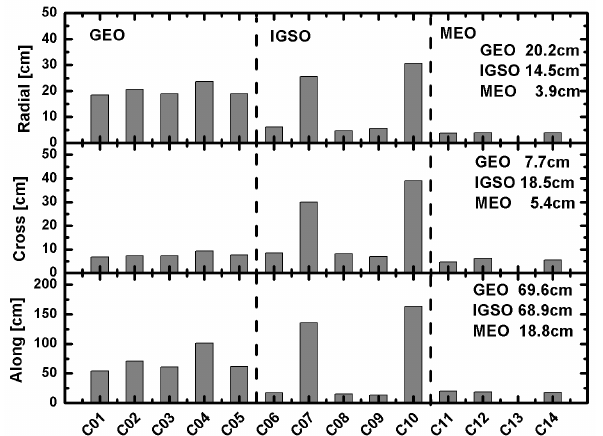
Figure 4. Mean RMS of BDS overlap comparison of the predict arcs with the post-processed solution.